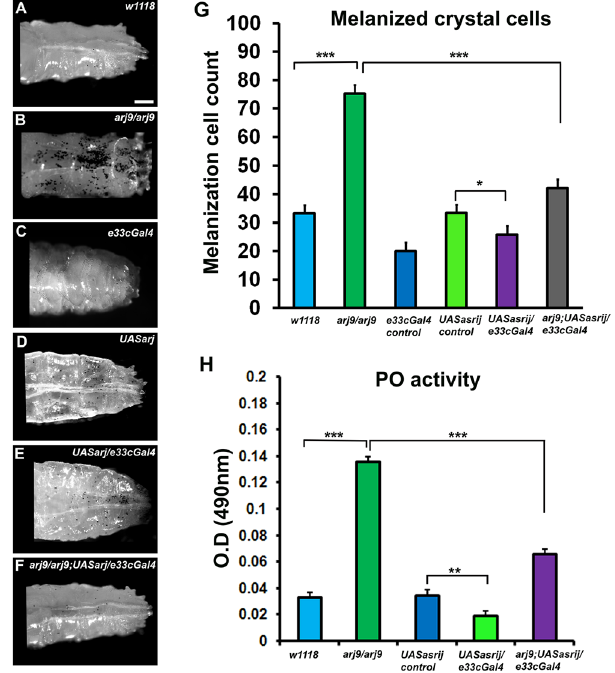
Figure 2. Asrij regulates crystal cell- mediated melanization and phenoloxidase activity. ( A – F ) Photomicrographs showing posterior region of third instar larvae of specific genotypes ( A ) w1118 ( B ) arj9 / arj9 ( C ) e33cGal4 ( D ) UAS arj ( E ) UAS arj / e33cGal4 ( F ) arj9 / arj9; UAS arj / e33cGal4 that were heated at 60 °C for 10 min to visualize the melanization response. ( G ) Melanized crystal cells were quantified and represented graphically. ( H ) Graph representing phenoloxidase activity in the hemolymph of the indicated genotypes (detected as absorbance at 490 nm) after conversion of L-3, 4-dihydroxyphenylalanine. Scale Bar: ( A – F ) 100 μ m. Number of larvae analyzed per genotype (n = 10). Error bars show standard error of mean. P-value: * , ** , *** indicate P < 0.05, P < 0.01 and P < 0.001